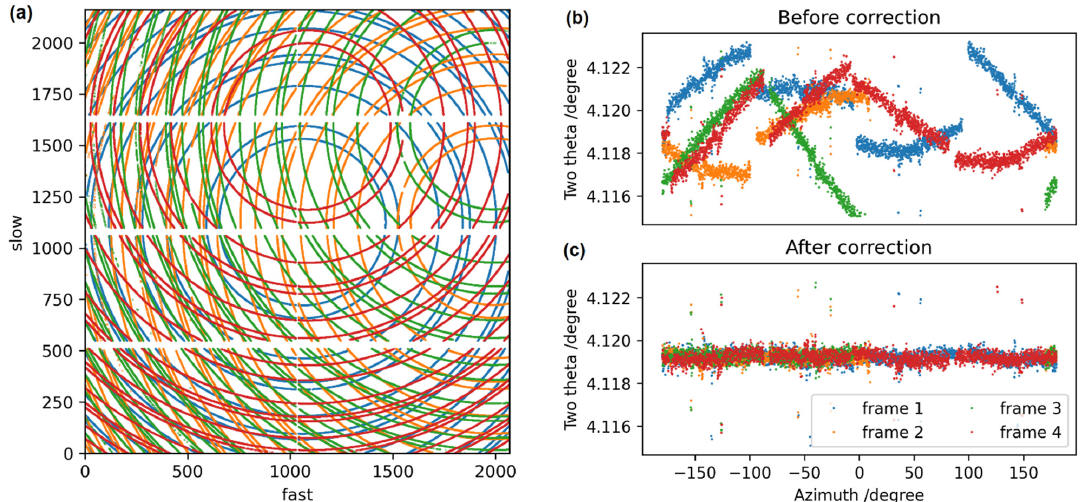
Figure 3. ( a ) Superposition of the Debye–Scherrer ring positions from the four calibration images where slow and fast refer to the pixel directions in the image. The variation of the Bragg angle (two theta) for the low angle (111) reflection from the CeO 2 powder data before ( b ) and after ( c ) applying the